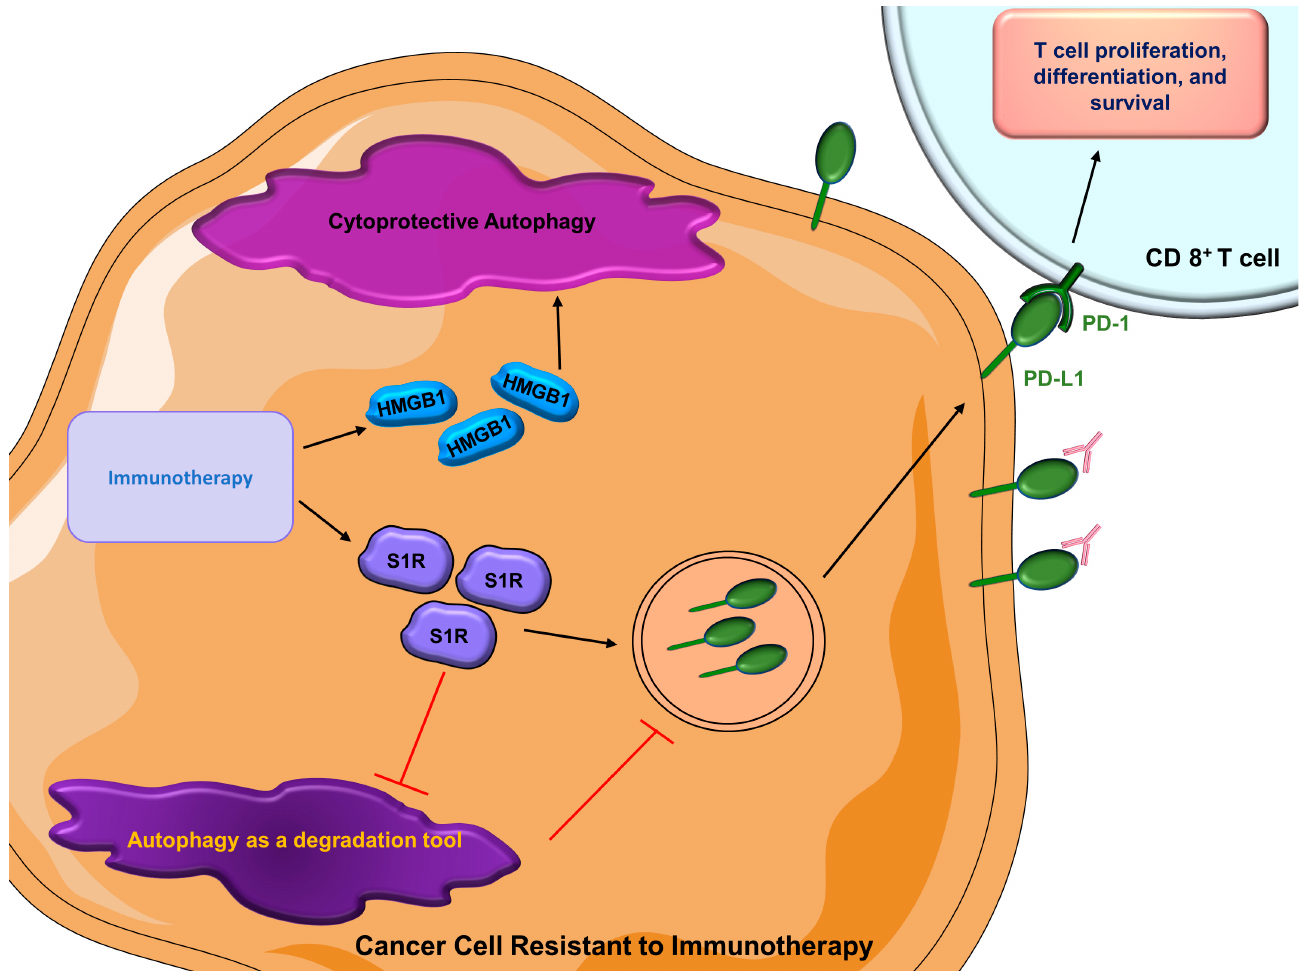
Figure 5. Roles of autophagy in cancer cells resistant to immunotherapy. Besides the activation of cytoprotective autophagy, cancer cells’ acquired immunotherapy resistance inhibits degradatory autophagy, thus increasing the amount of surface PD-L1 to interfere with the efficacy of immunotherapy. (HMGB1 = high mobility group box 1; PD-1 = programmed cell death protein 1; PD-L1 = programmed death-ligand 1; S1R = Sigma 1 receptor).